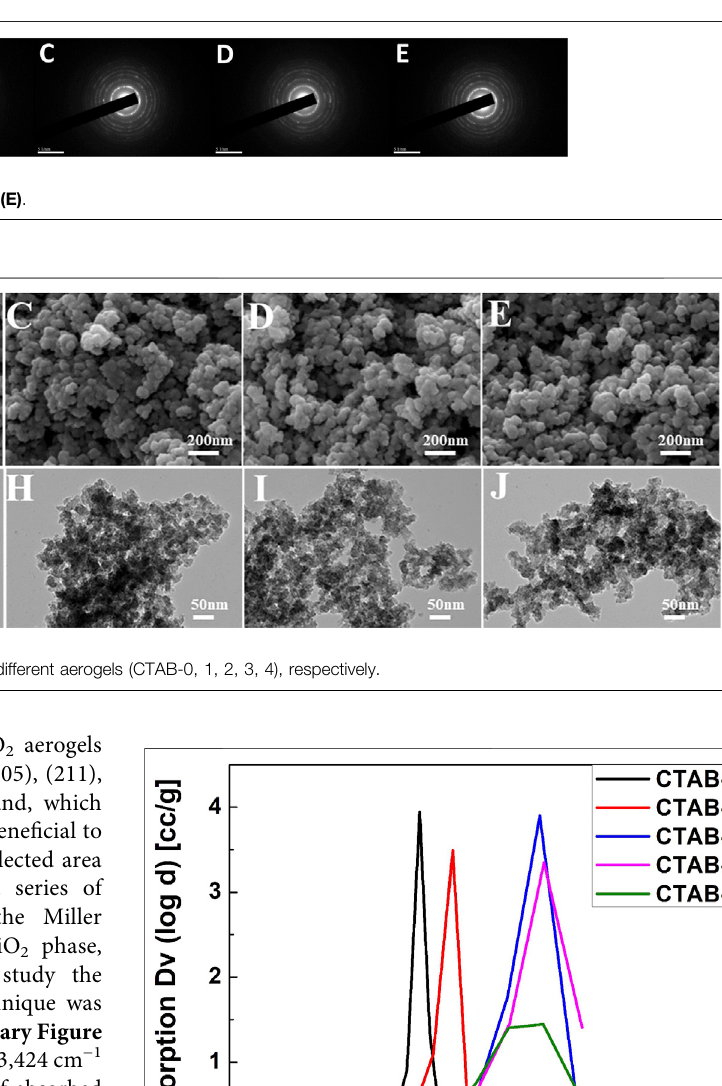
increase of the pore size. But in our work, there is a suitable